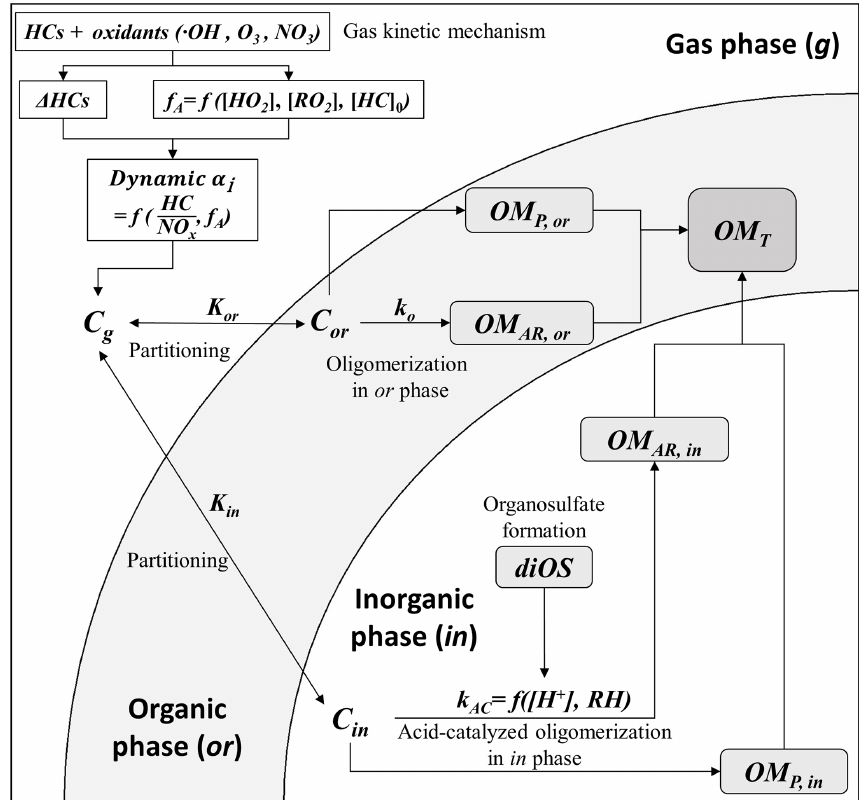
Figure 1. Simplified scheme of the UNIPAR model. [HC] 0 represent the initial hydrocarbon (HC) concentration. The dynamic mass-based stoichiometric coefficient (dynamic α i ), the consumption of HCs ( (cid:49) HCs), the concentration of hydroperoxide radical ([HO 2 ]), and the con- centration of organic peroxyl radical ([RO 2 ]) are simulated from the gas kinetic mechanism (MCM v3.3.1). The aging scale factor ( f A ) is represented as a function of [HO 2 ], [RO 2 ], and [HC] 0 , which is detailed in Sect. 3.1. C and K denote the concentration and the partitioning coefficient of organic compounds, respectively, in gas phase ( g ), organic phase (or), and inorganic phase (in). k or ,i denotes the reaction rate constant of oligomerization of organic compounds in the organic phase. k AC ,i denotes the reaction rate constant of acid-catalyzed oligomer- ization of organic compounds in the inorganic phase and is determined as a function of aerosol acidity ([H + ]) and ambient humidity (RH). “OM” represents the concentration of organic matter. Subscripts “AR”, “ P ”, and “ T ” indicate OM formed from aerosol-phase reactions, OM formed from the partitioning process, and total OM, respectively. Subscript i represents each lumping species. diOS represents the concentration of organosulfate – dialkyl sulfate (diOS) in this